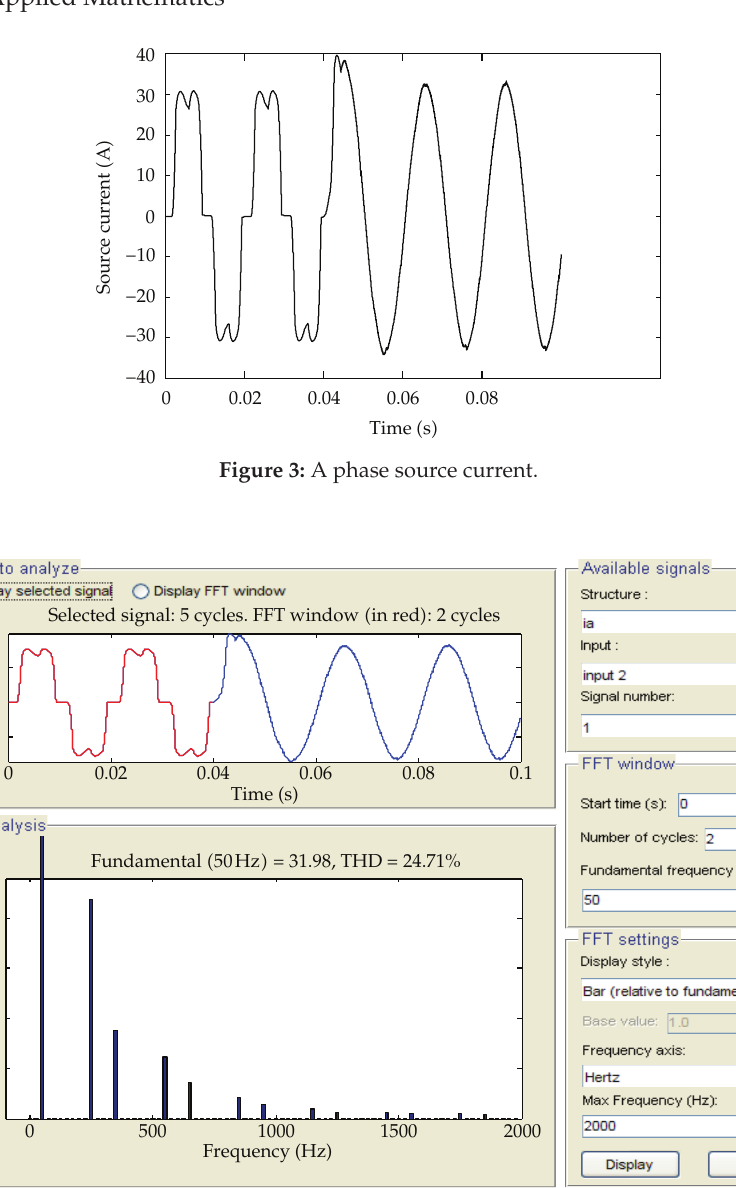
Figure 4: Current harmonic analysis for the first two